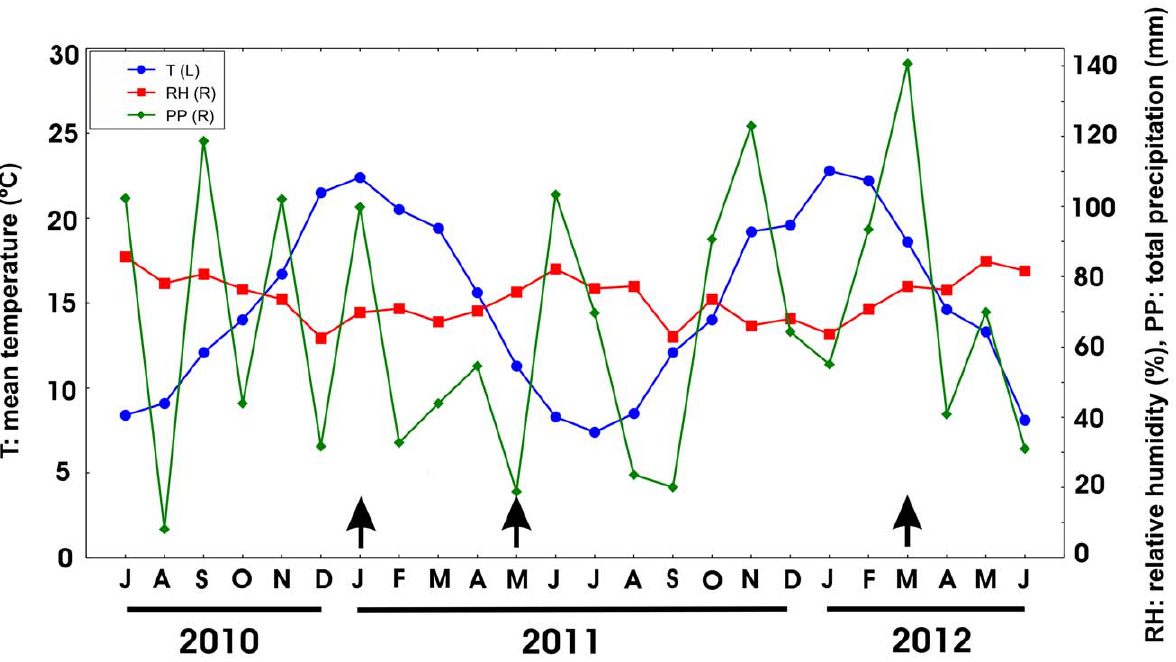
Figure 2. Weather conditions of the studied area, from July 2010 to June 2012. On the left mean temperature in u C (T), on the right % of relative humidity (RH) and total precipitation in mm (PP). http://www.tutiempo.net/clima. Arrows indicate sampling